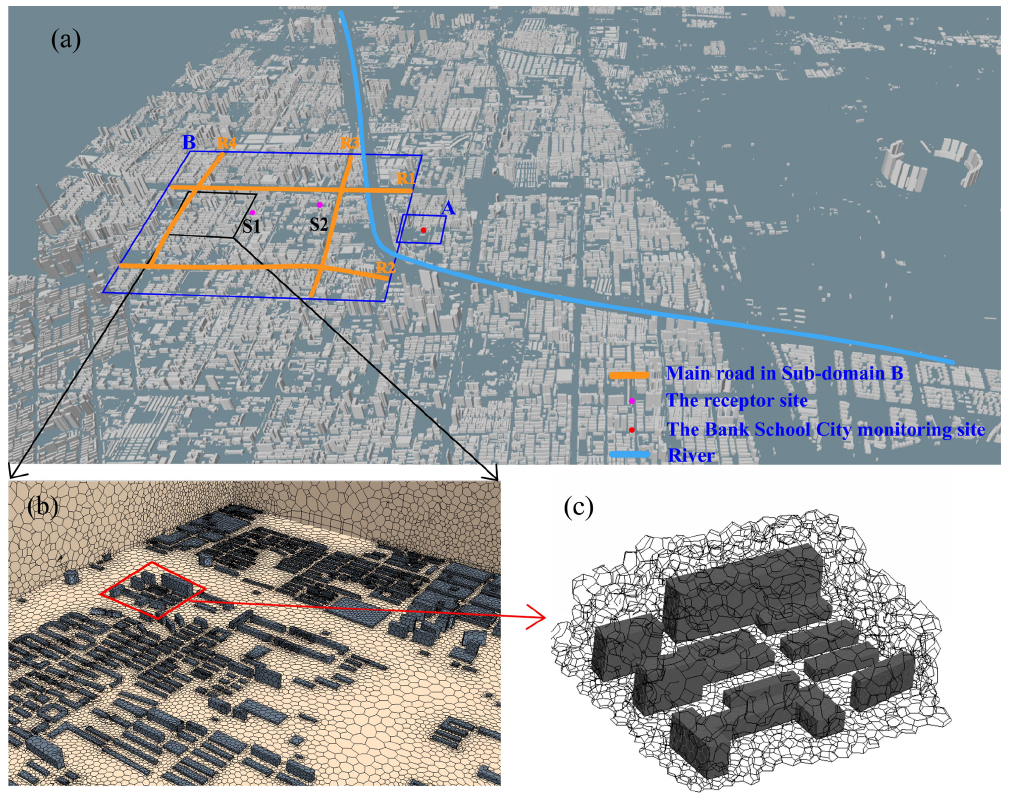
Figure 3. The computational domain of STAR-CCM+ is shown in (a) . The sub-domain A is used for detailed analysis of the wind environ- ment, and the Bank School City (BSC) monitoring site is marked with the red dot. Sub-domain B is used to analyse the potential contribution of traffic sources to receptor sites in the region, with magenta dots (S1 and S2) indicating the receptor sites and orange lines indicating the main roads. The polyhedral mesh is used to divide the STAR-CCM+ simulation area. The mesh details of the vertical cross section and building surface are shown in (b) , and the 3D meshes are shown in (c) .